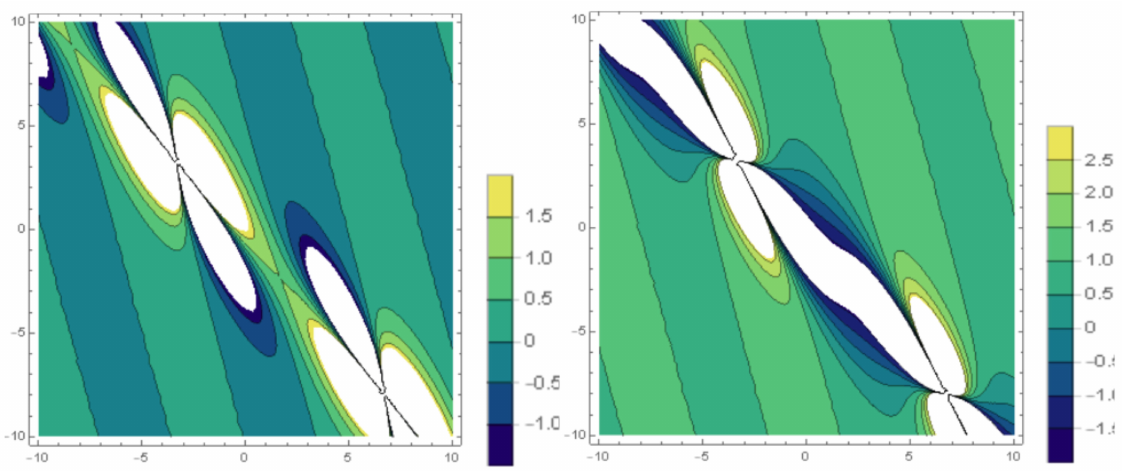
Figure 9. The contour surfaces of Equation (22) under the values of ε = 0.4, − 15 < x < 15, − 15 < t <